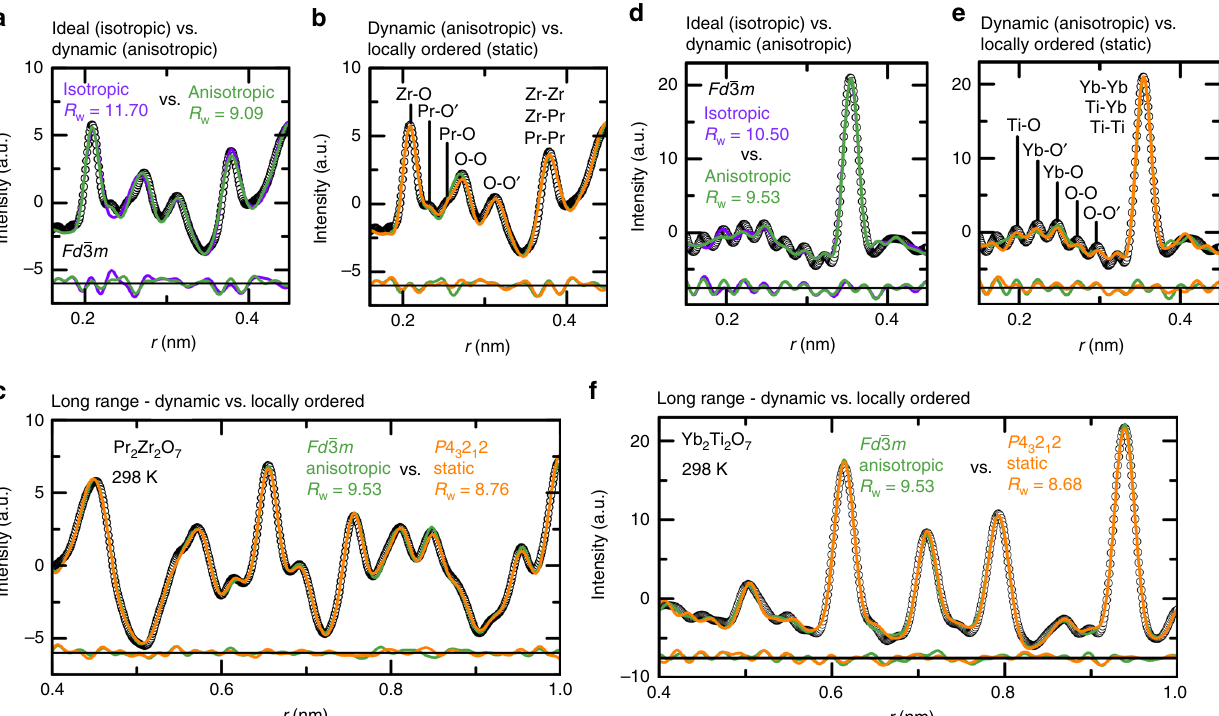
Fig. 3 Neutron and X-ray Pair Distribution Function analyses on Pr 2 Zr 2 O 7 and Yb 2 Ti 2 O 7 , respectively. Time-of- fl ight neutron PDF for Pr 2 Zr 2 O 7 re fi nements focusing on a and b short length scales and c longer length scales. Synchrotron X-ray PDF for Yb 2 Ti 2 O 7 focusing on d and e short length scales and f longer length scales. Re fi nements for the ideal model (isotropic displacement parameters) are shown in purple, dynamic displacements (anisotropic displacement parameters) are shown in green, and lower symmetry P 4 3 2 1 2, locally ordered displacements (static) are shown in orange. Difference curves match their respective re fi nement colors and data is shown as black circles